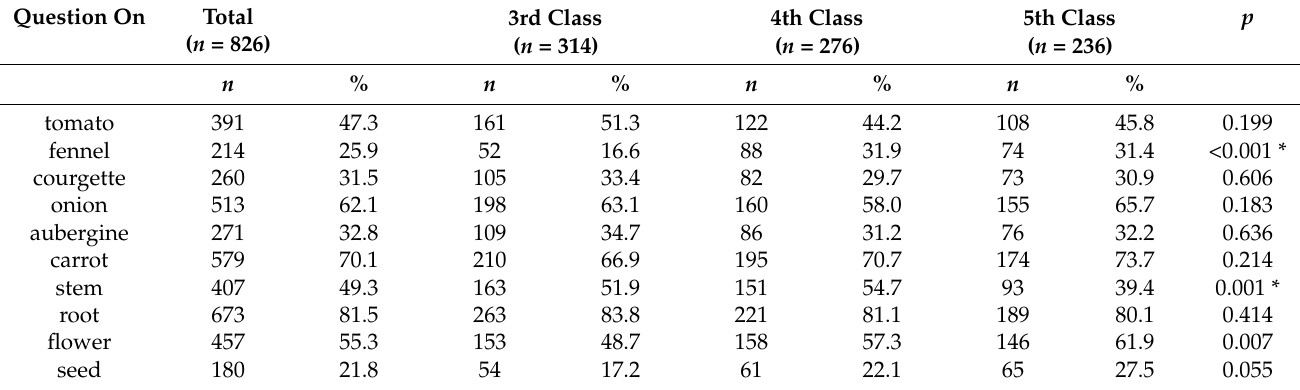
Table 4. Assessment of students’ basal knowledge on fruit and vegetables.